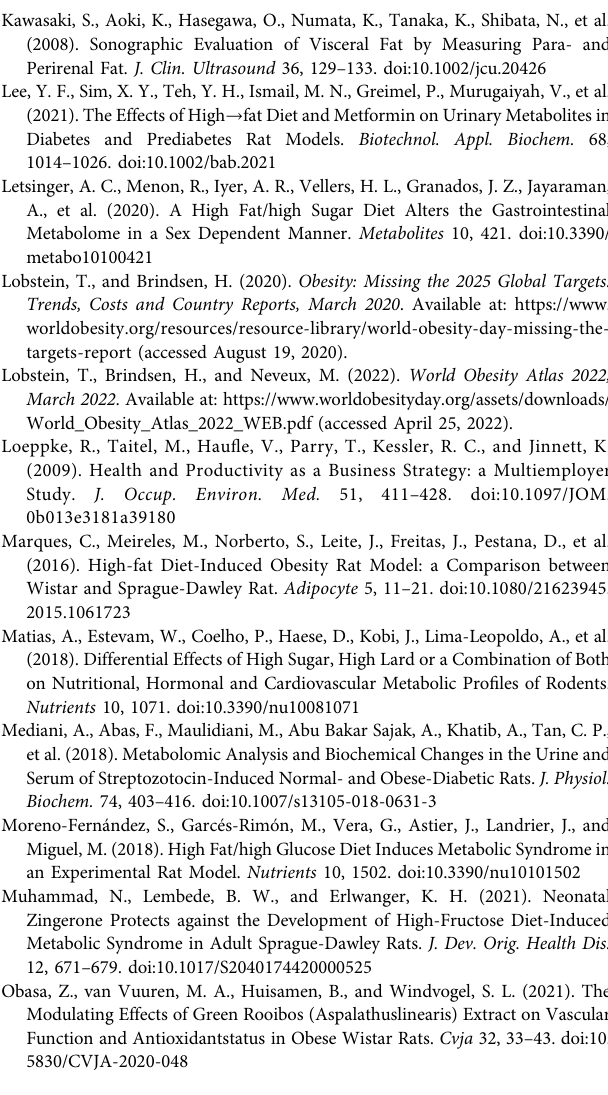
Supplementary Figure S1 | Receiver Operating Characteristic (ROC) curve for the OPLS-DA model. TPR, true positive rate; FPR, false positive rate. Yellow = CON; blue = OB1; red =